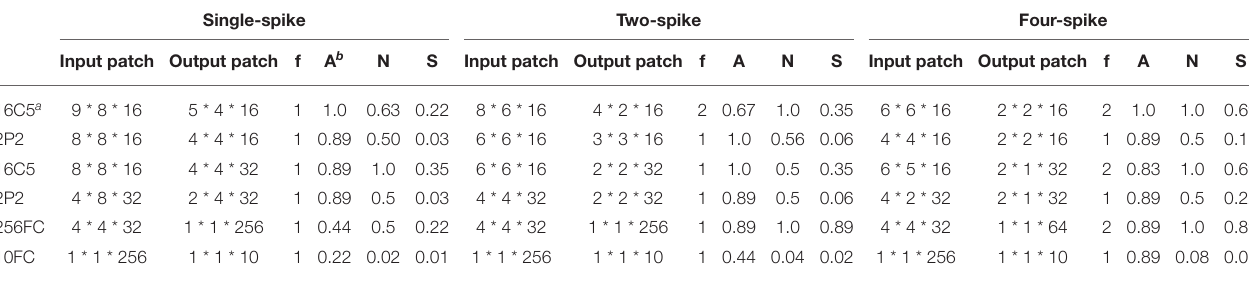
TABLE 7 | Mapping results for LeNet. Single-spike Two-spike Four-spike